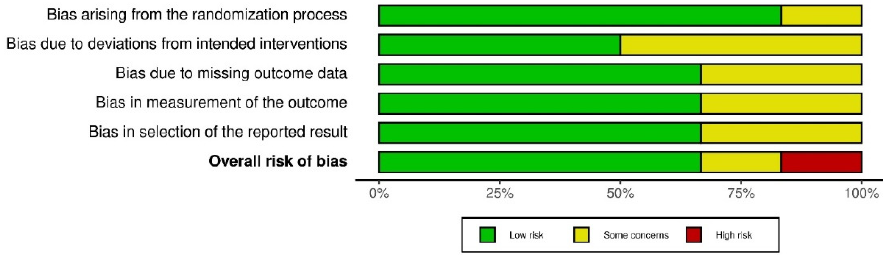
Figure 2. Assessment of risk of bias in the RCTs with the aid of the RoB tool, for individual domains and individual RCTs.